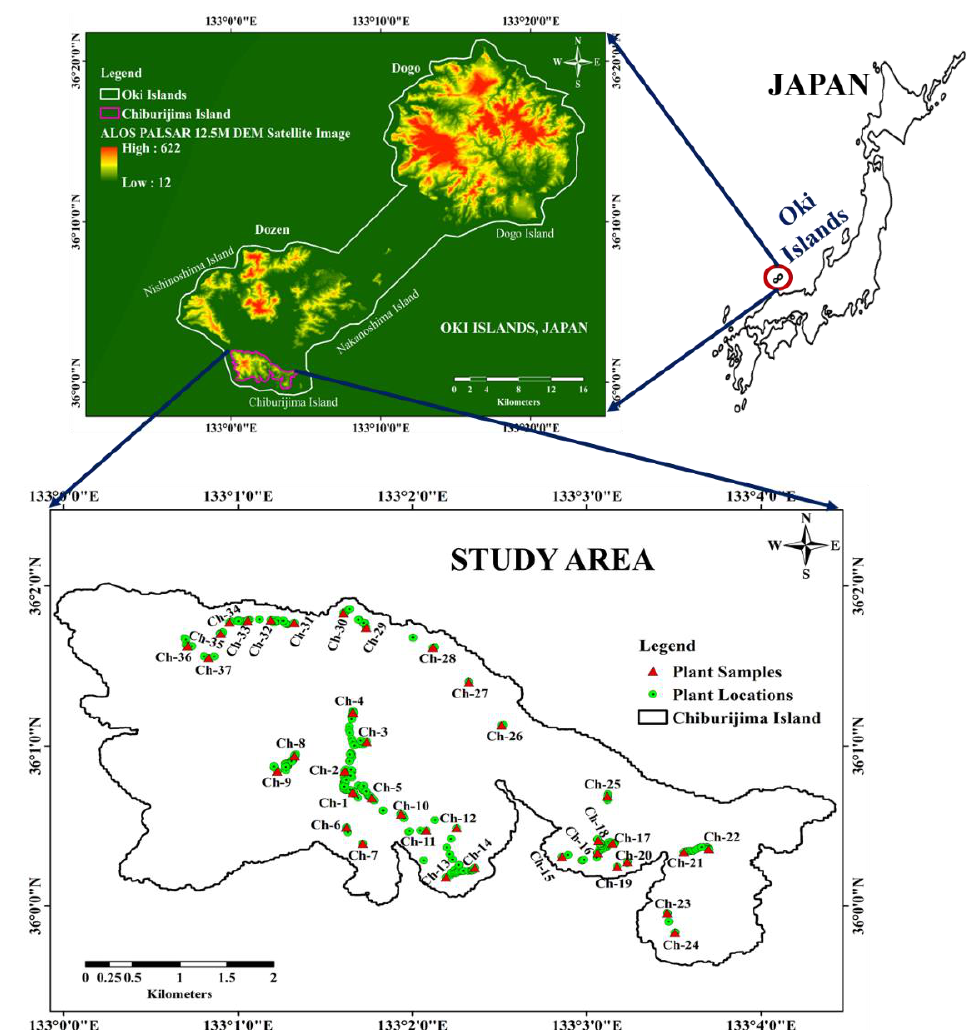
Figure 5. Plant locations and sample map of study area, which comprises an area of 11.4 km 2 of Chiburijima. Map was prepared using ALOS PALSAR DEM satellite image and ArcGIS version 10.5.1 (Licensed).